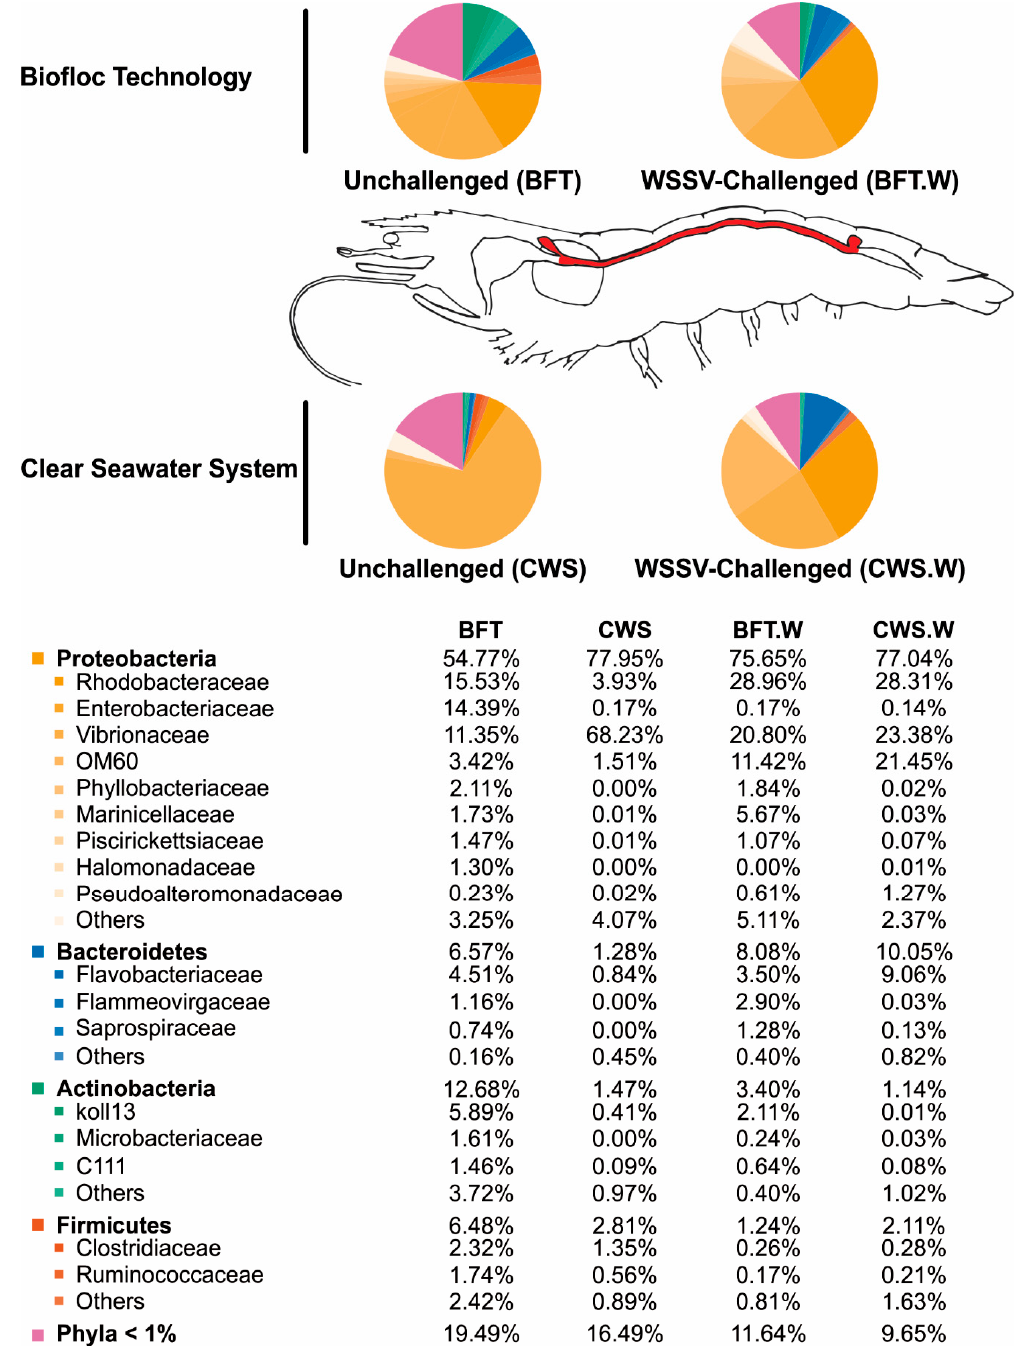
Figure 4 . Relative abundance of the most prevalent bacterial phyla and families identified in the midgut of Litopenaeus vannamei (highlighted in red in the not-to-scale image) reared in biofloc (BFT) and clear seawater (CWS), and at 48 h after an oral challenge by the White spot syndrome virus (BFT.W and CWS.W).